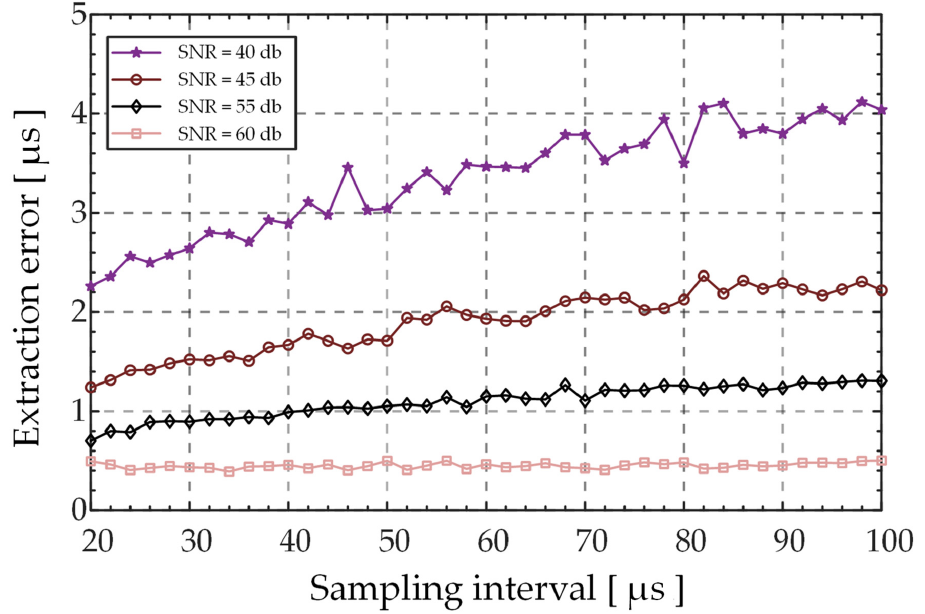
Figure 4. Prediction accuracy at zero-crossing time t 0 as a function of the sampling interval at different SNR